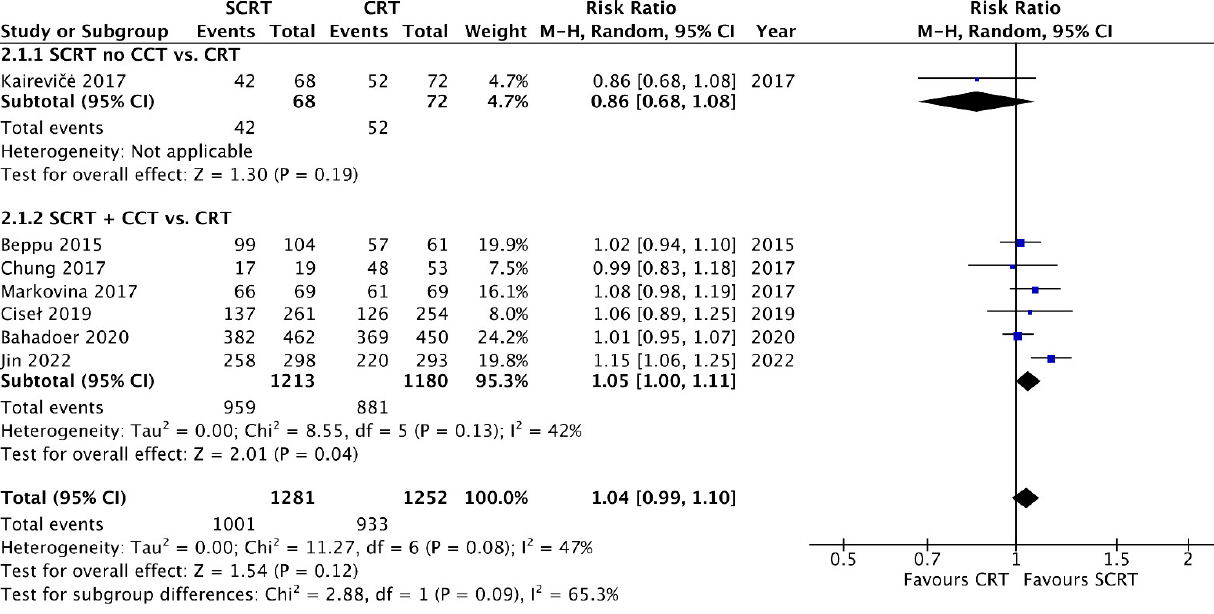
Figure 4. Forest plot of overall survival (OS) events by Risk ratio (RR).